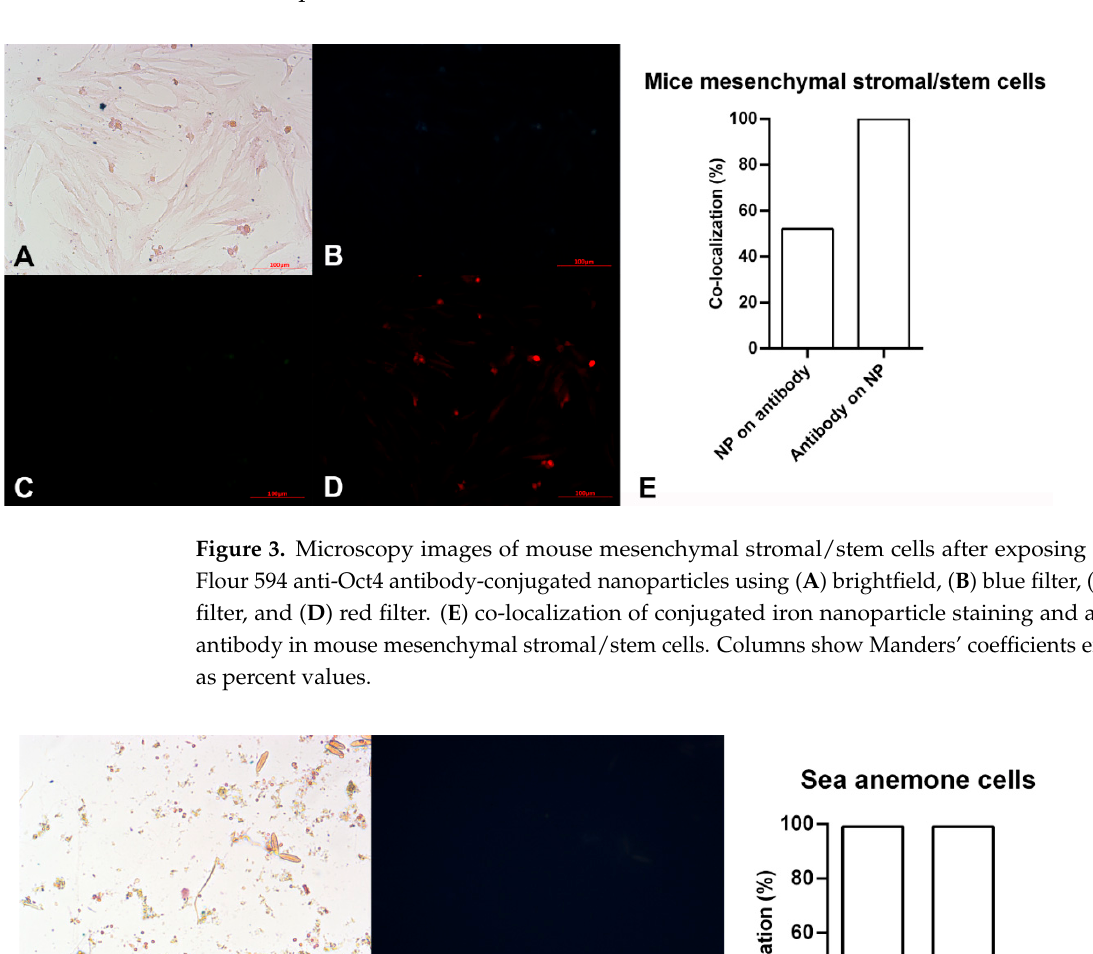
Figure 2. Microscopy images of Alexa Flour 594 anti-Oct4 antibody-conjugated nanoparticles using ( A ) brightfield, ( B ) blue filter, ( C ) green filter, and ( D ) red filter.